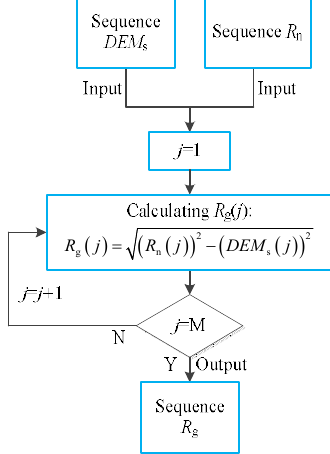
Figure 9. Flow chart of calculating the sequence R g.